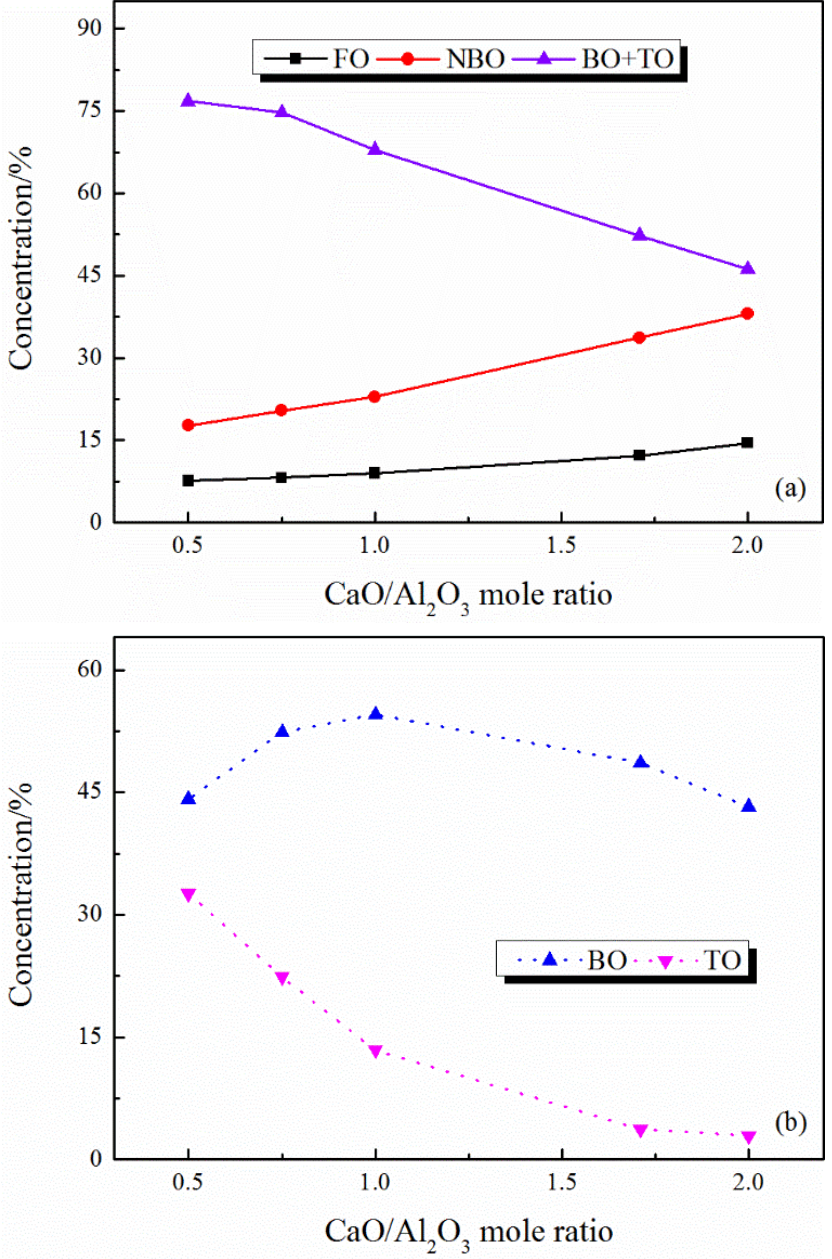
Figure 3. Distribution of oxygen types in CaO – Al 2 O 3 melts with different CaO/Al 2 O 3 mole ratios: ( a ) the initial distribution; ( b ) the refined distribution of networked structural oxygen.